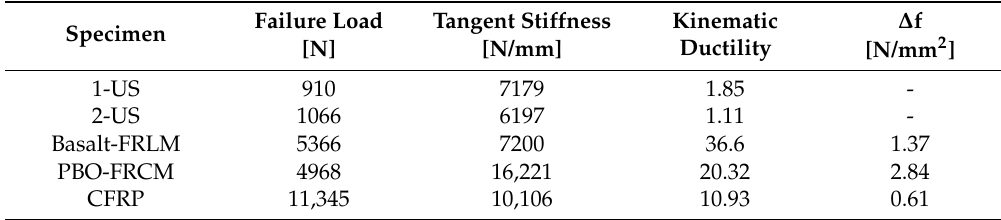
Table 3. Structural parameters identified during tests on arch models.